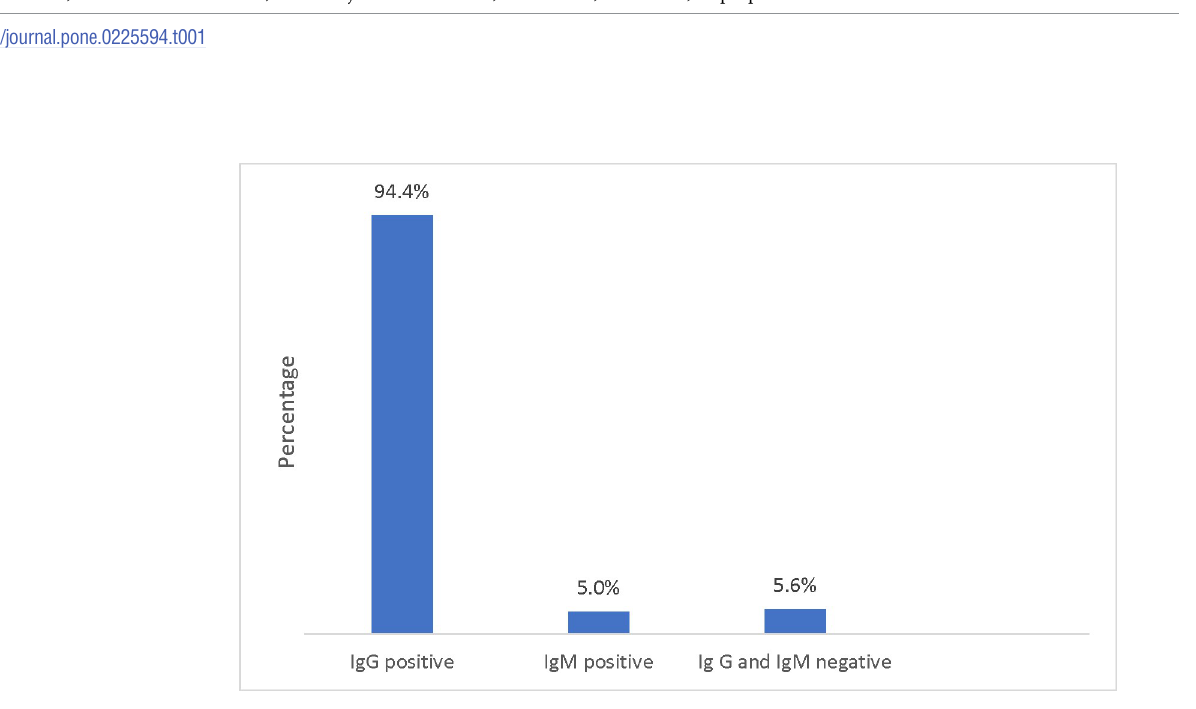
Fig 1. Rubella immune status of pregnant women in the center and South-West regions of Cameroon. IgG positive: indicates the proportion of participants with indication of protective immunity; IgM positive indicates possible rubella infection; IgG and IgM negative indicates no immunity to